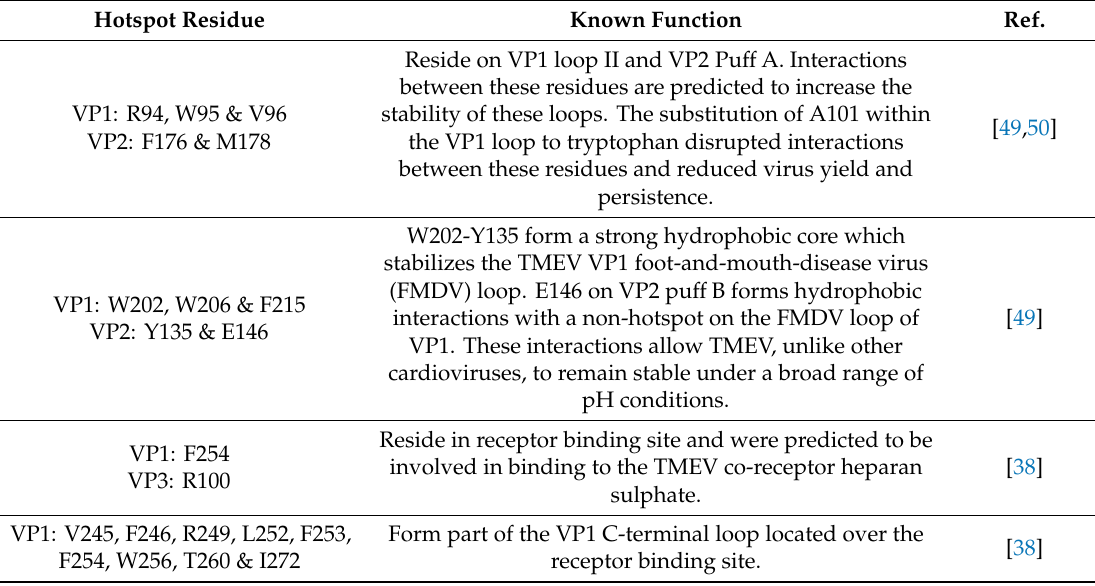
Table 3. Intraprotomer hotspot residues in TMEV with previously known